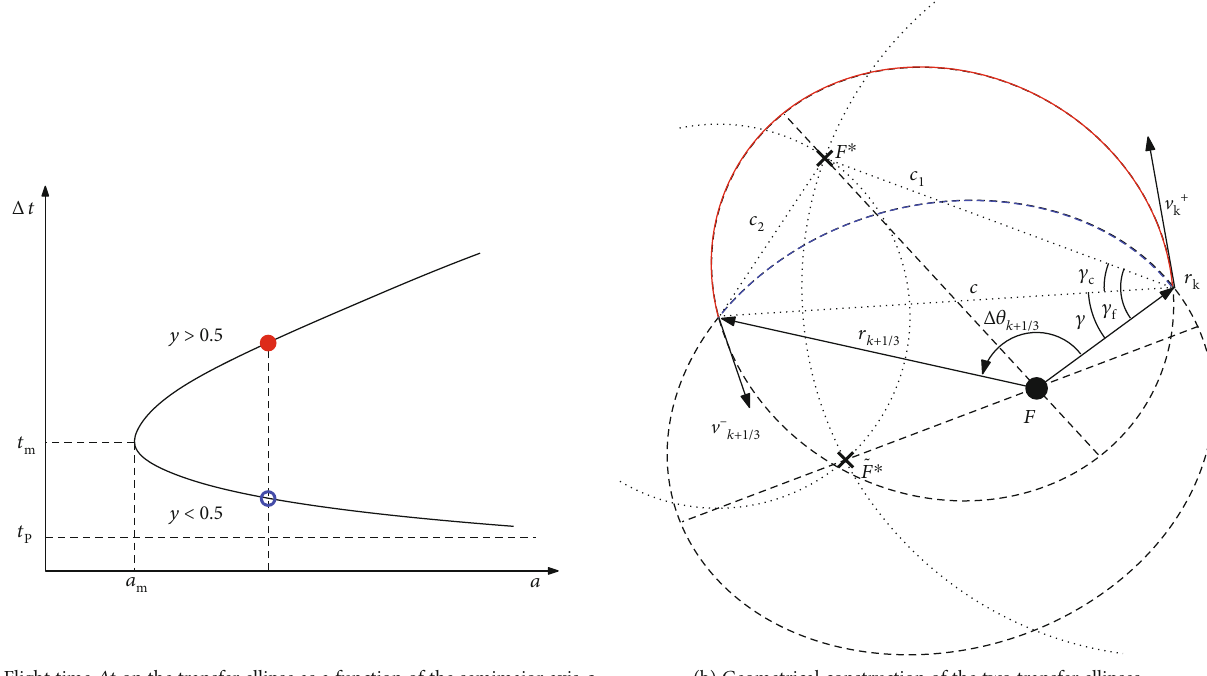
Figure 2: Geometrical problem. The fi lled marker in (a) refers to the slow solution that corresponds to the solid-line transfer arc in (b); the empty marker in (a), instead, refers to the fast solution, represented with a dashed line in